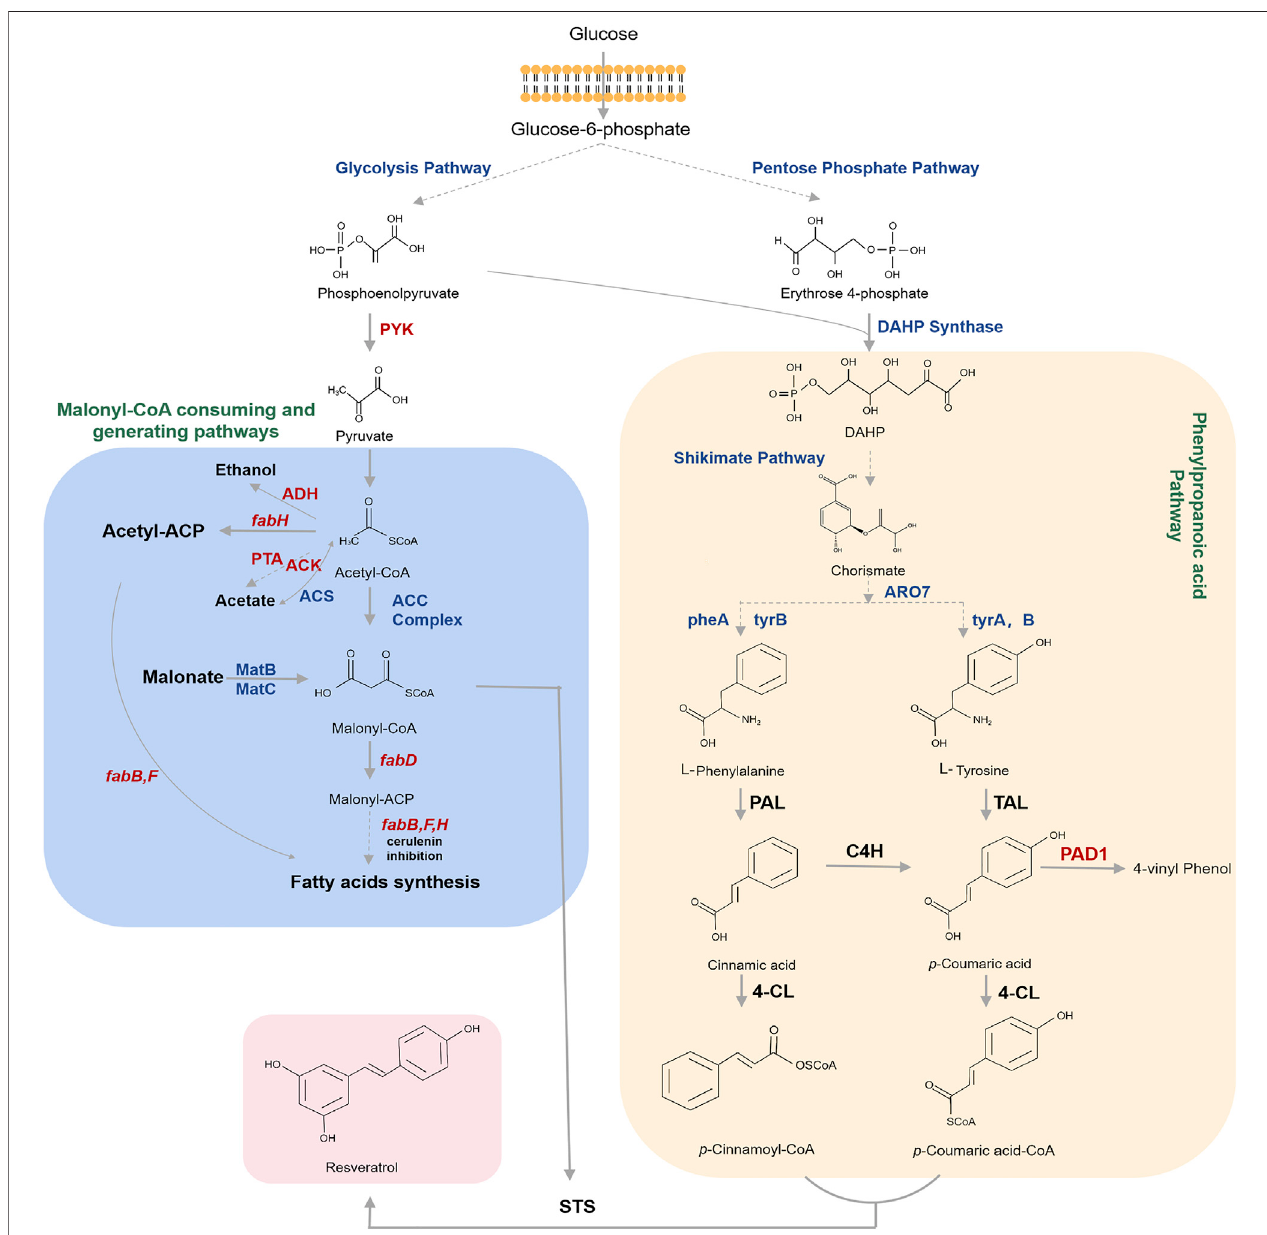
FIGURE 3 | Biosynthetic pathway for resveratrol starting from glucose. The pathways for generating precursors of resveratrol biosynthesis such as phenylpropanoyl-CoAs and malonyl-CoA are highlighted. Dotted arrows refer to multiple steps. Genes and enzymes in blue are targets for overexpression. Genes and enzymes in red are targets for knockout or inhibition. Note that the malonate is externally supplied. DAHP Synthase, 3-deoxy- D -arabinoheptulosonate-7-phosphate (DAHP) synthase; DAHP, 3-deoxy-D arabinoheptulosonate 7- phosphate; ARO7, chorismate mutase; ARO7, chorismate mutase; tyrA/pheA, genes that encode the chorismate mutase protein; tyrB, gene that encodes the tyrosine aminotransferase; PAL, phenylalanine ammonia lyase; TAL, tyrosine ammonia-lyase; C4H, cinnamate 4-hydroxylase; PAD, phenyl acrylic acid decarboxylase; 4CL, 4-coumaroyl-coA ligase; STS, stilbene synthase; PYK, pyruvate kinase; Acetyl-CoA, acetyl- coenzyme A; ADH, alcohol dehydrogenases; fabH, gene that encodes 3-oxoacyl carrier protein synthase III; PTA, phosphate acetyltransferase; ACK, acetate kinase; ACS: acetyl-CoA synthase; Acetyl-ACP, acetyl-acyl carrier protein; ACC complex, acetyl-coA carboxylase multienzyme complex; Malonyl-CoA, malonylcoenzyme A; MatB, malonyl-CoA synthetase; MatC, malonate carrier protein; fabD, gene that encodes the malonyl-CoA-acyl carrier protein transacylase; Malonyl-ACP, malonyl-acyl carrier protein; fabB/fabF, genes that encode the beta-ketoacyl-acp synthase I/II protein.